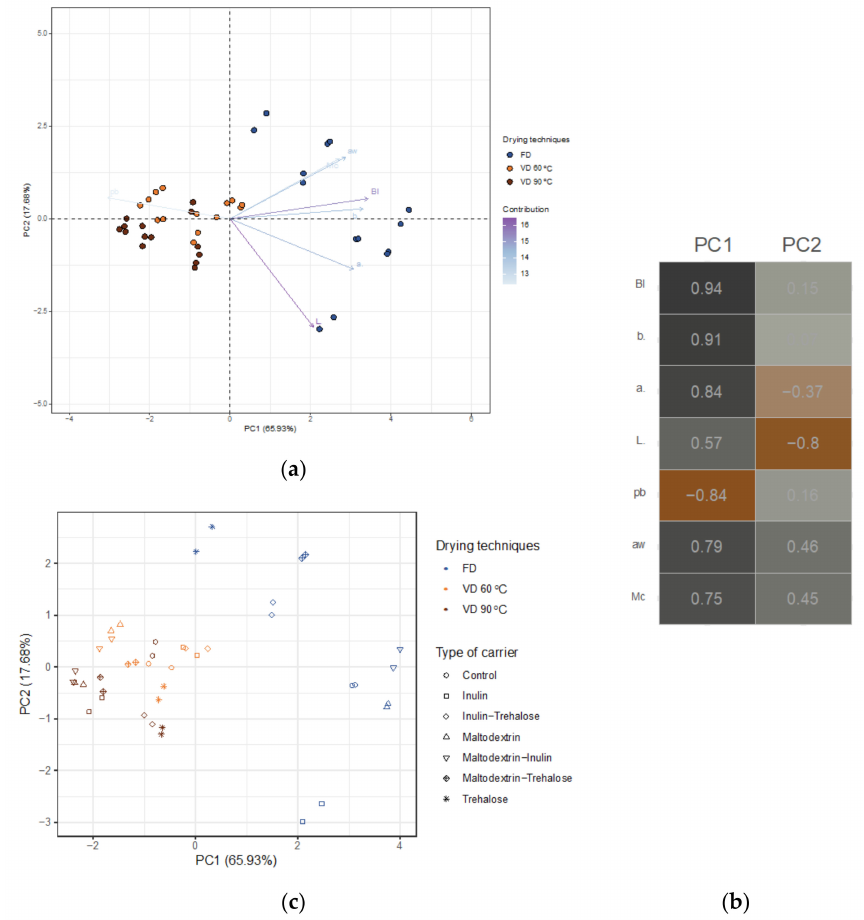
Figure 1. ( a ) The PCA biplot of the first two principal components that simultaneously shows PC scores of chokeberry pomace extract powders (points) and loadings of explanatory variables (vectors). The marker colour corresponds to the drying techniques (i.e., freeze and vacuum drying at 60 and 90 ◦ C), while the length and the transparency of the arrows indicate the variance of the physical properties of powders from chokeberry pomace extracts and their contributions to the principal components, respectively. Together, the first two principal components explain 83.61% of the variability; ( b ) The plot of normalised factor loadings that quantify the extent to which the explanatory variable is related with a given principal component. Applying the so-called Malinowski rule (i.e., normalised factor loading cut-off of |0.70|) simplifies assigning physical meaning to each principal component; ( c ) Score plot in the space defined by the first two principal components illustrating relations and trends of chokeberry pomace extract powders gained after freeze and vacuum drying at 60 and 90 ◦ C with the addition of maltodextrin (M), inulin (I), trehalose (T), maltodextrin—inulin (M—I), maltodextrin—trehalose (M—T), and inulin—trehalose